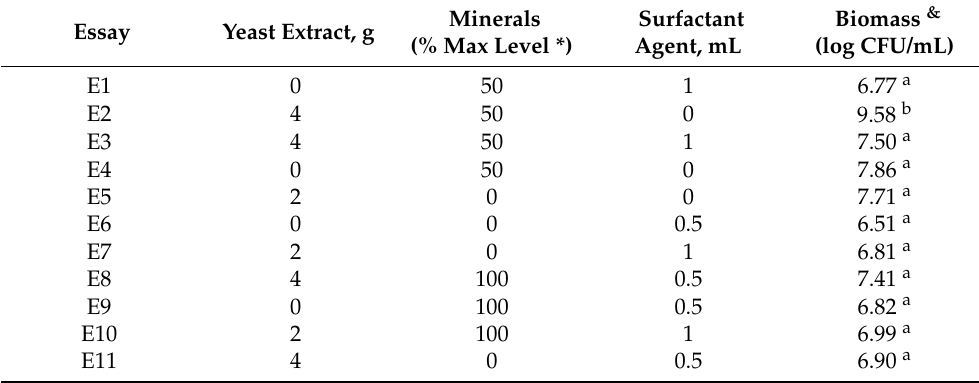
Table 2. Ingredients and their amounts accompanying molasses for each MCM liter and biomass produced in the assays of Box–Behnken